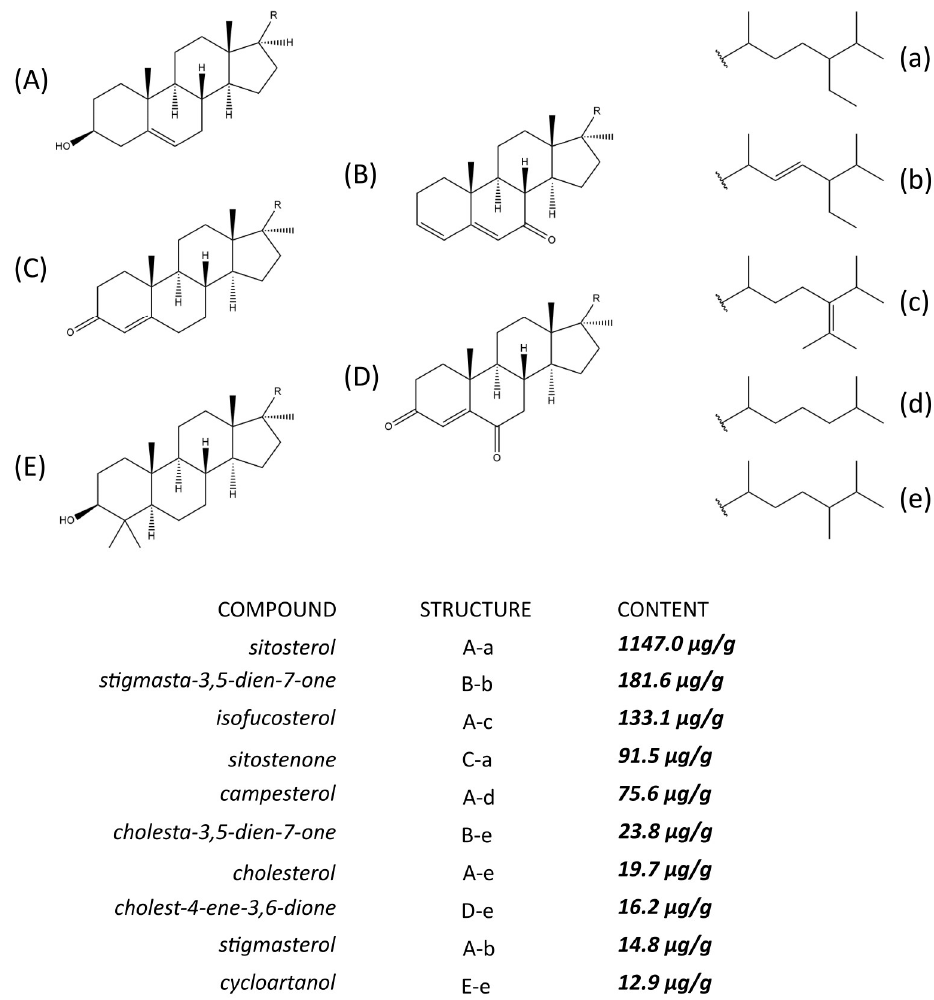
Figure 3. Sterols and their derivatives present in the apple pomace.